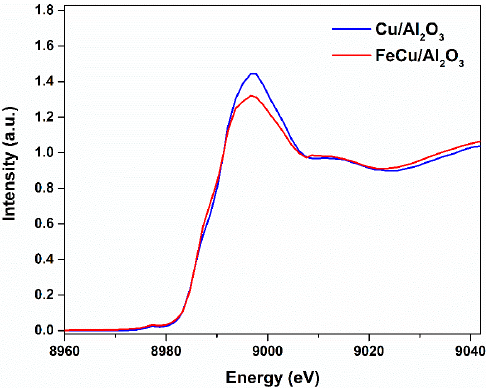
Figure 7. Normalized Cu K-edge XANES spectra of Cu/Al 2 O 3 and FeCu/Al 2 O 3 catalysts. As mentioned above, CO oxidation follows a Mars van-Krevelen reaction